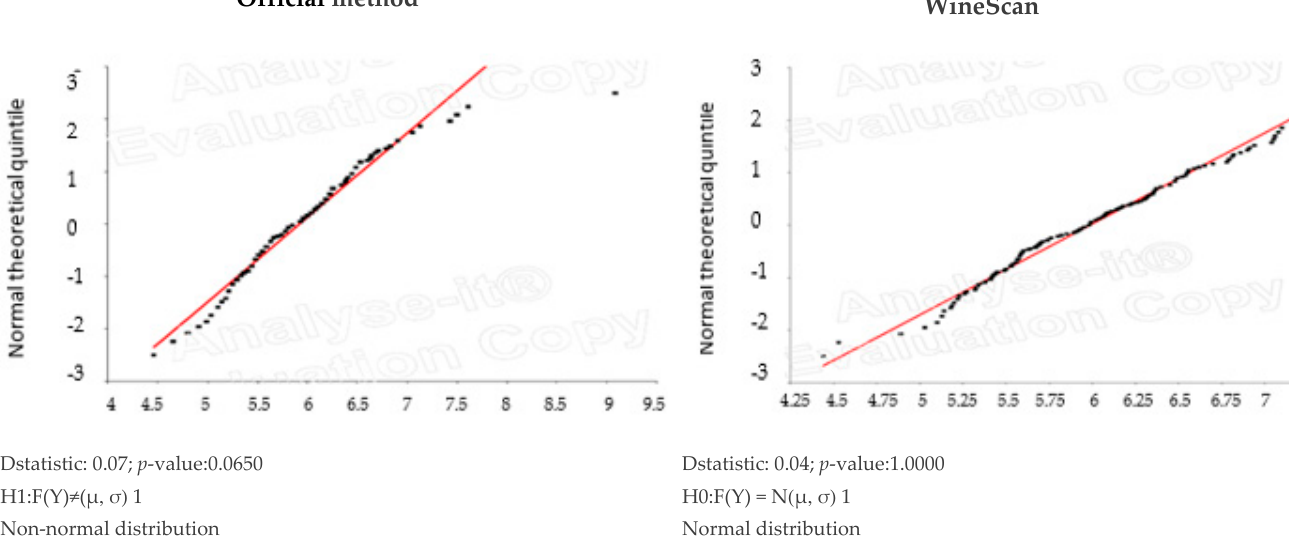
Figure 11. Statistical differences (Kolmogorov–Smirnov test) between total acid concentration results obtained by the official method and WineScan technology. The continuous line represents the normal distribution. The dashed dots represent the observed distribution.